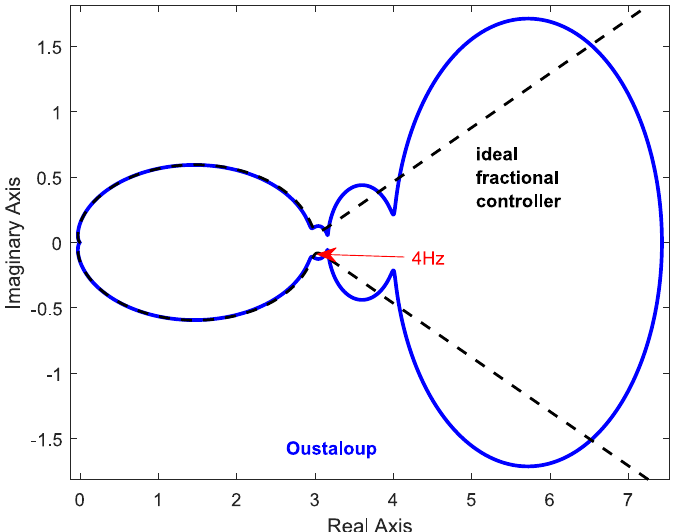
Figure 3. Nyquist characteristics for a magnetic levitation system with the PI λ D controller. The controller parameters are K p = 100, K i = 5, λ = 0.75 and K d = 4. The analytical characteristics are marked by the black dashed line. The blue line represents the characteristic with the controller approximated by the Oustaloup’s method with parameters: order 5 and frequency bound between 10 − 4 and 10 3 . The cut-off frequency is marked in red on the chart for which the difference between the analytical system and its approximation can be